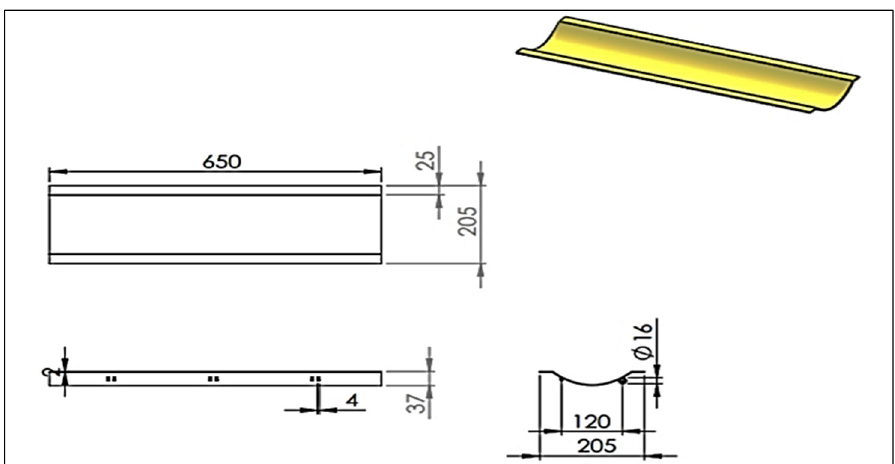
Figure 10. Schematic view of the spring-loaded tray of the Aashkol.